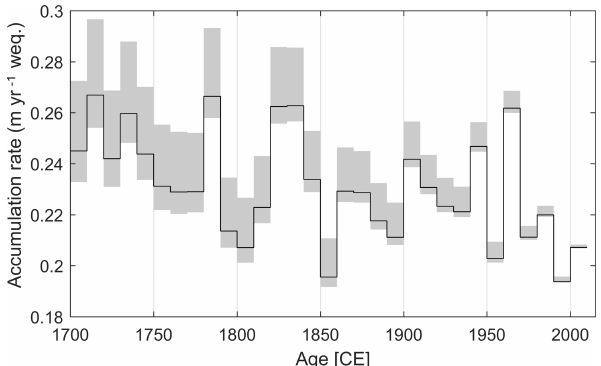
Figure 13. Accumulation reconstructions since 1950CE for the three Roosevelt Island ice cores described in Table